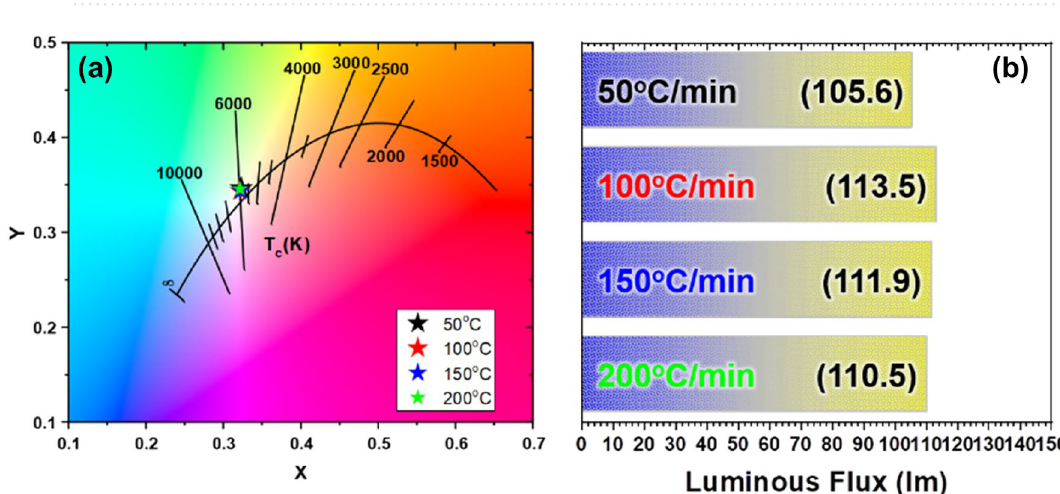
Figure 4. Optical properties of CPs prepared according to the heating rate in the range (50–200)